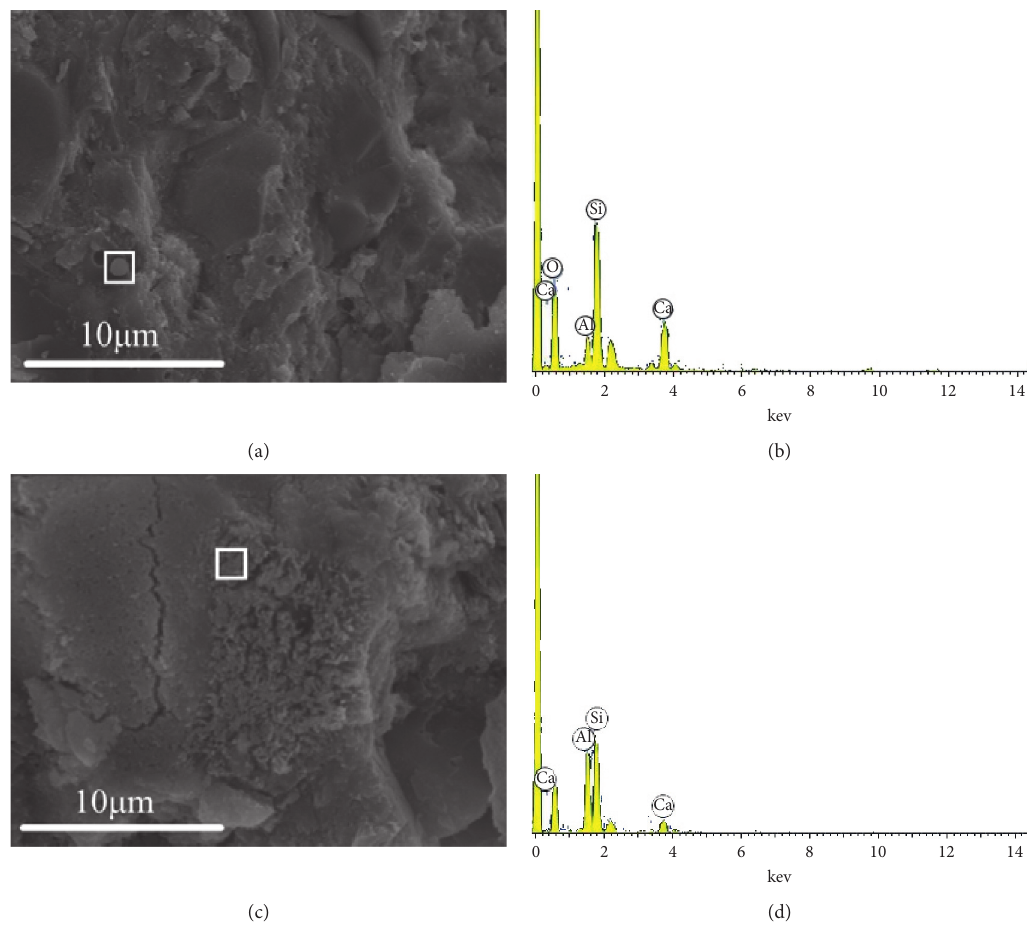
Figure 11: The SEM images and EDS patterns of submicron SiO 2 and submicron aluminosilicate of the HCS at a curing period of 3 days: (a) SEM image of SiO 2 ; (b) EDS pattern of SiO 2 ; (c) SEM image of aluminosilicate; (d) EDS pattern of aluminosilicate.